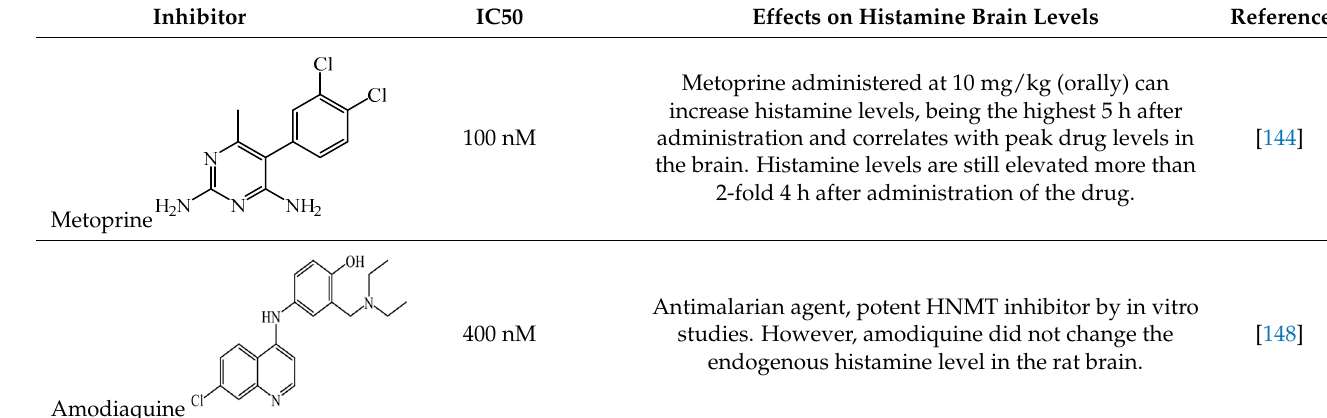
Table 1. Pharmacological characteristics of HNMT inhibitors.